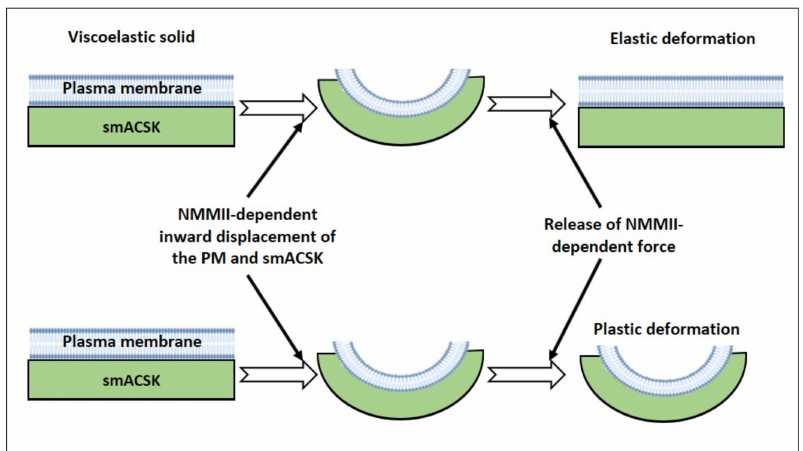
Figure 4. Illustration of behavior of a viscoelastic solid composed of the plasma membrane (blue rectangle) and the underlining submembrane cytoskeleton (green rectangle). Upper panel: in case of elastic deformation of the PM-smACSK under NMMII-generated pulling force the PM-smACSK completely restores its shape after the relaxation of NMMII. Lower panel: in case of the plastic deformation of the PM-smACSK, the PM-smACSK retains its deformed shape even after relaxation of